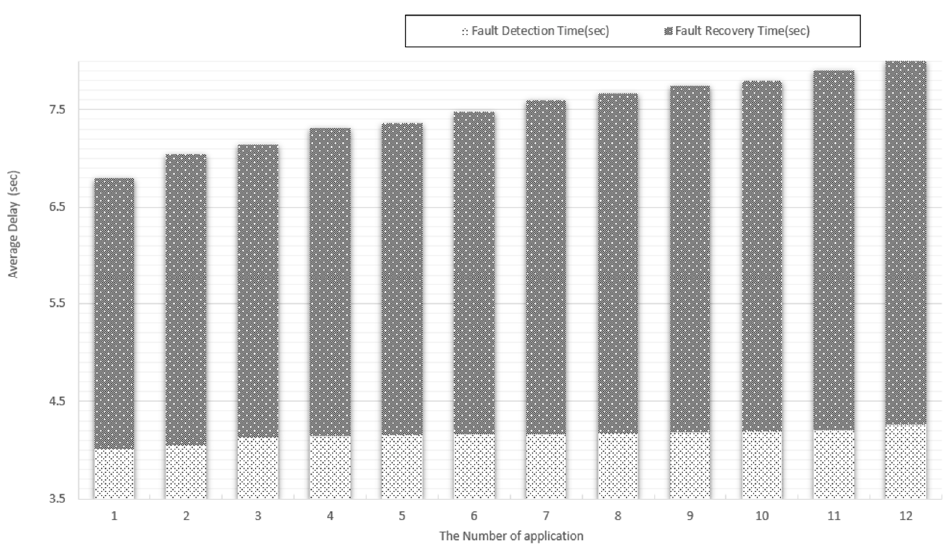
Figure 14. Multiple service fault monitoring performance .